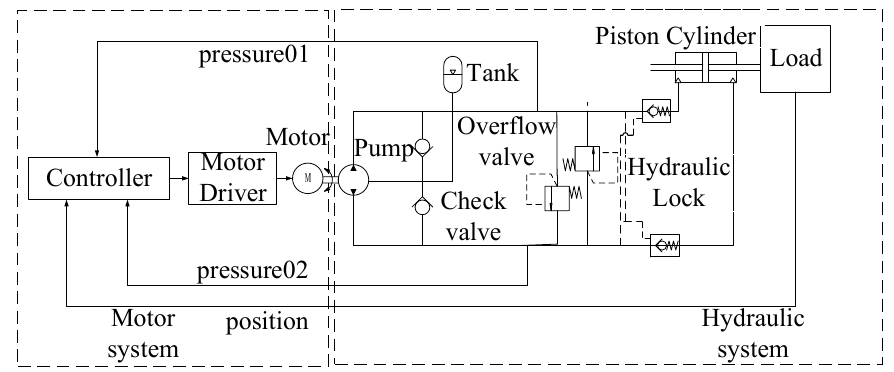
Figure 1. Schematic structure of BHL-EHA.